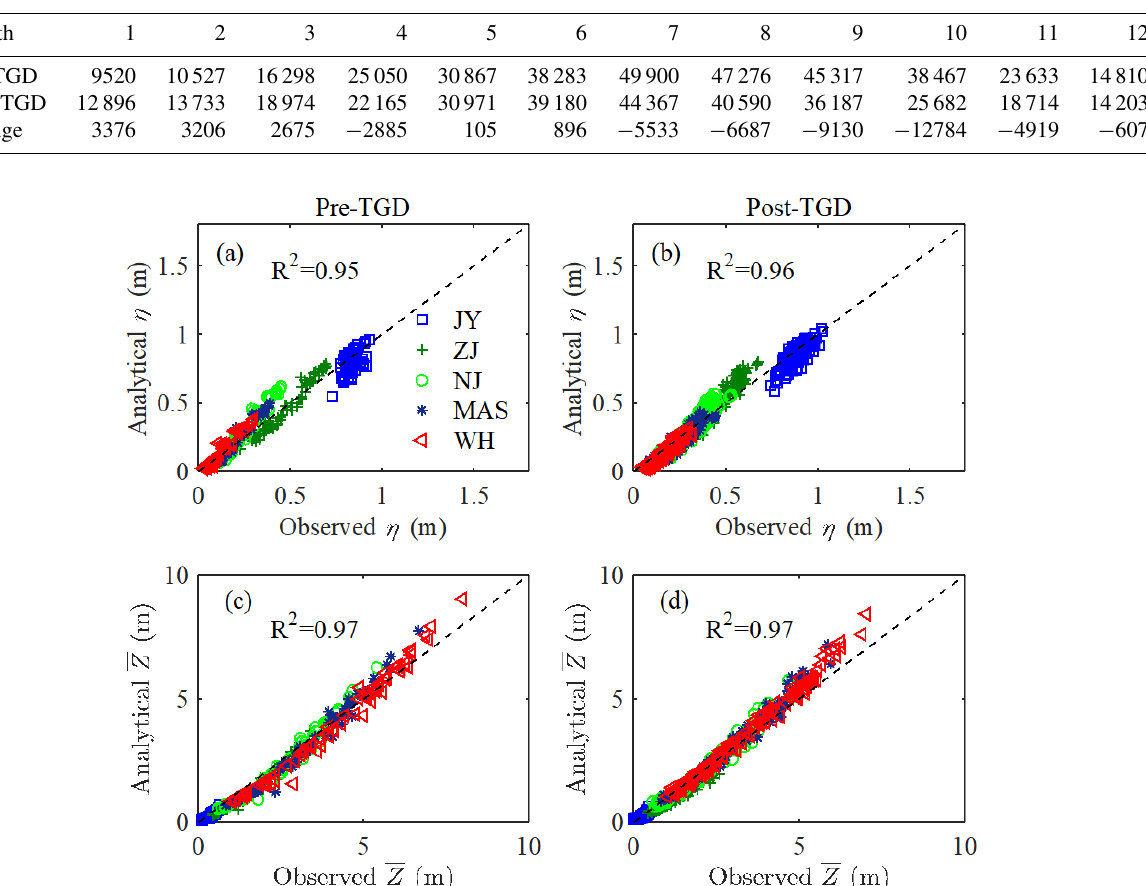
Table 2. Comparison of multi-year monthly averaged river discharge Q (m 3 s − 1 ) between the pre-TGD and post-TGD periods.